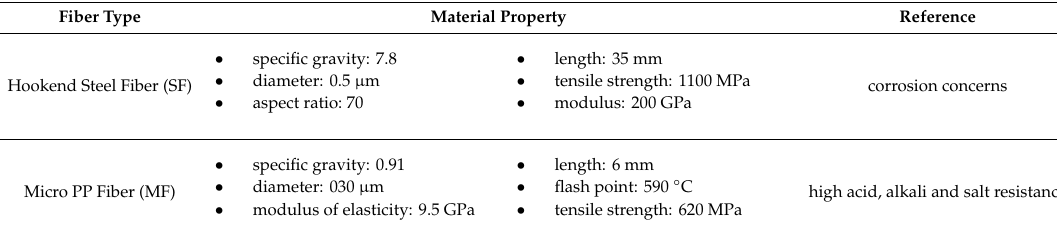
Table 1. Material property of reinforced